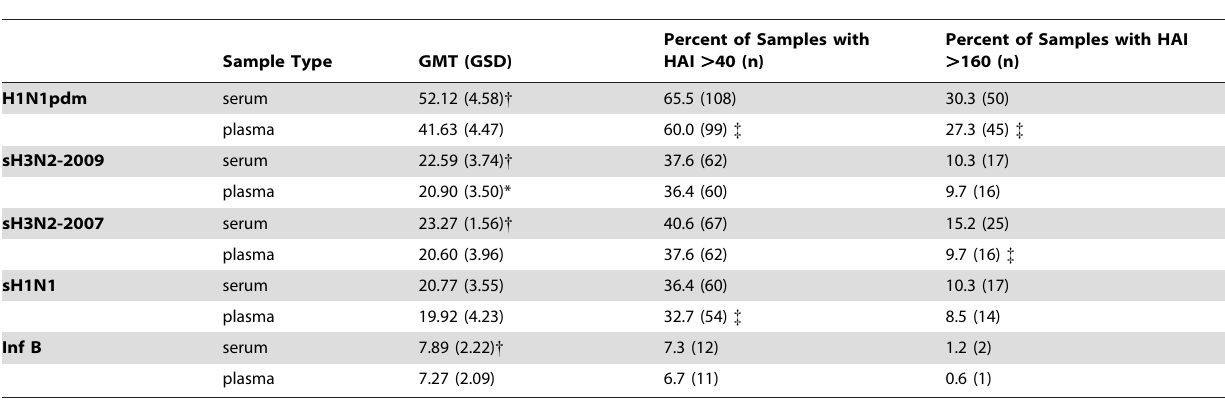
Table 1. Comparison of HAI data for 165 paired serum-citrated plasma samples for five influenza viruses.